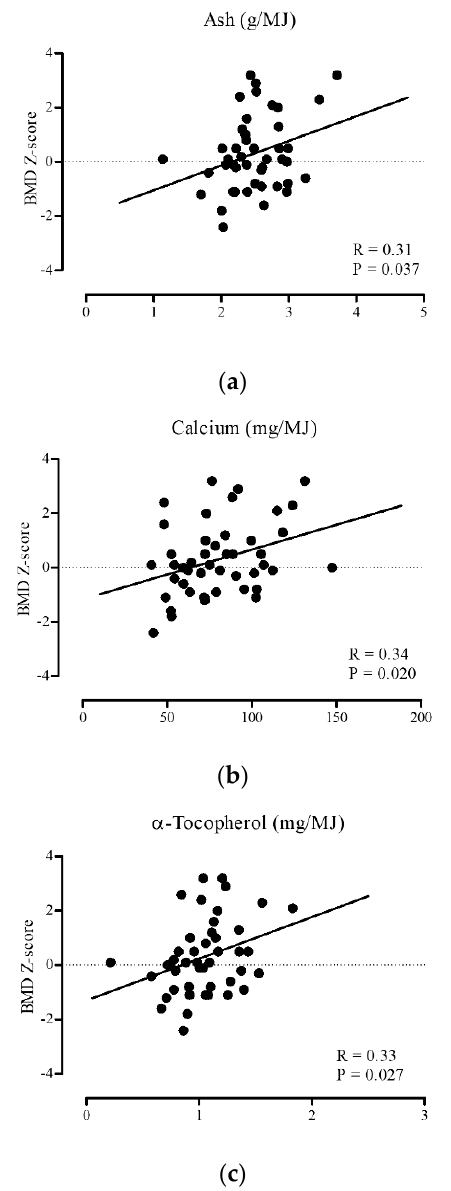
Figure 1. Correlations between BMD Z-score and daily intakes of ( a ) ash, ( b ) calcium, and ( c ) α -tocopherol in premenopausal women. BMD, bone mineral density. Significant positive correlations were found between BMD Z-score and the intake of ash, calcium, and α -tocopherol in premenopausal women.